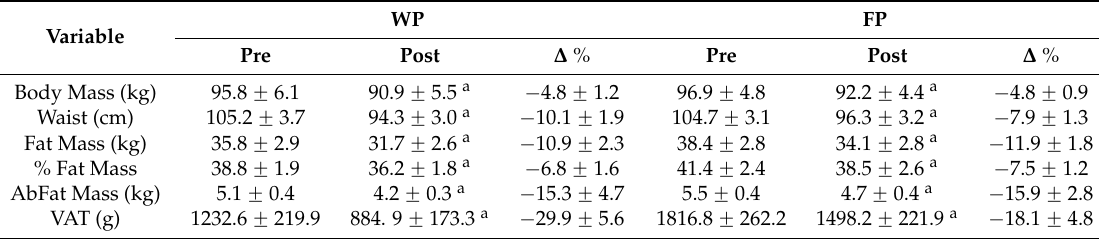
Table 2. Body composition measures at baseline and post-intervention.